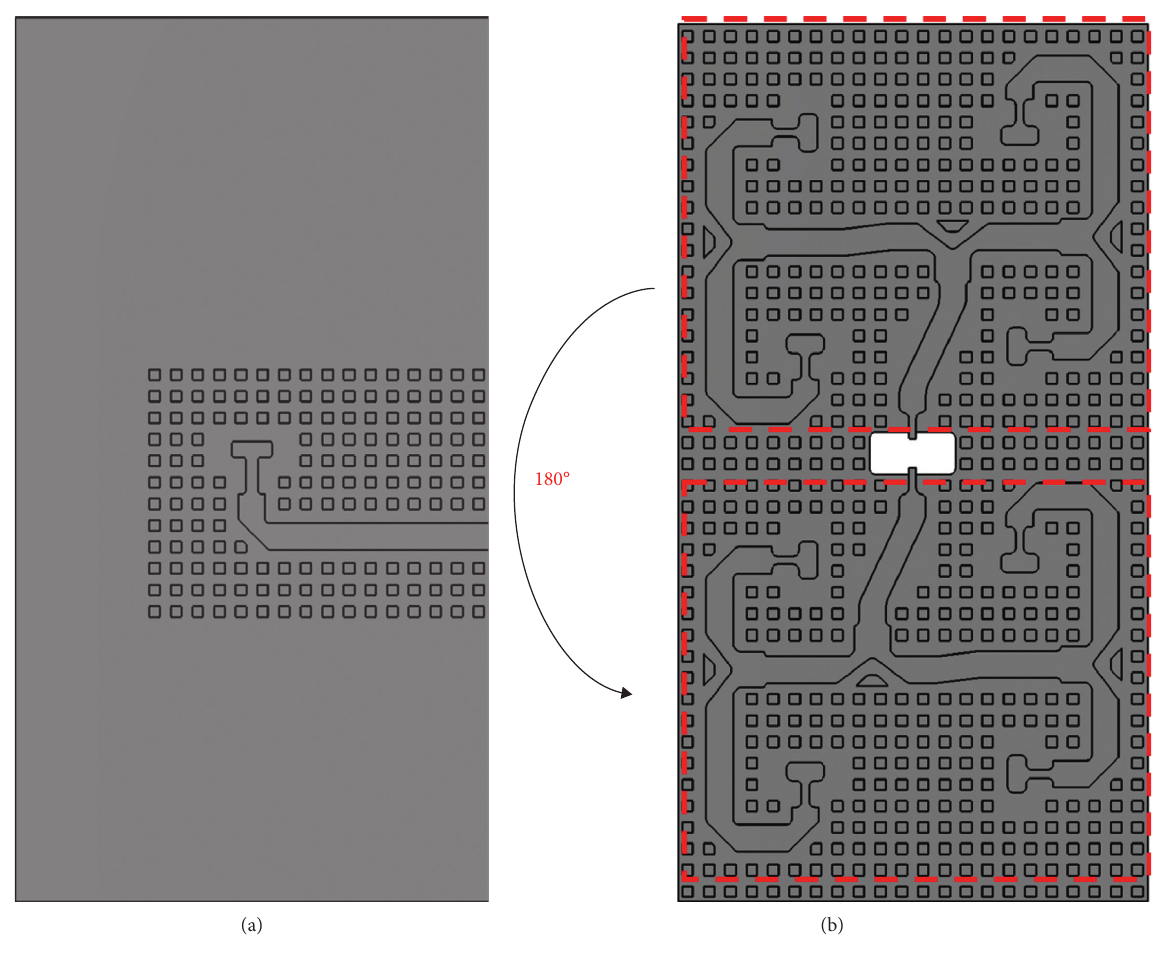
Figure 9: Feeding network layers of a 4 × 8 array. (a) Feed-2. (b) Feed-1.